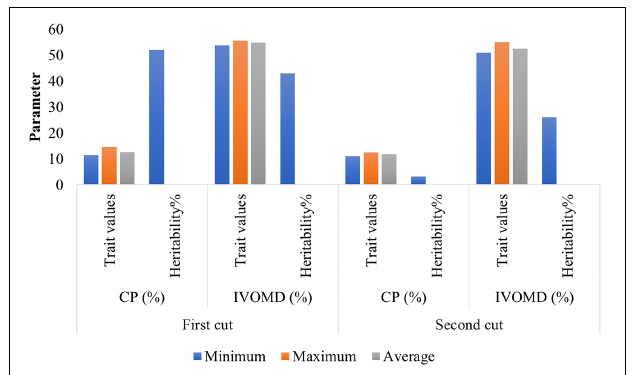
FIGURE 1 | Phenotypic performance of hybrid parents for the forage quality traits in 105 hybrid parents (Set-III) during summer seasons of 2015 and 2016 at International Crops Research Institute for the Semi-Arid Tropics (ICRISAT),